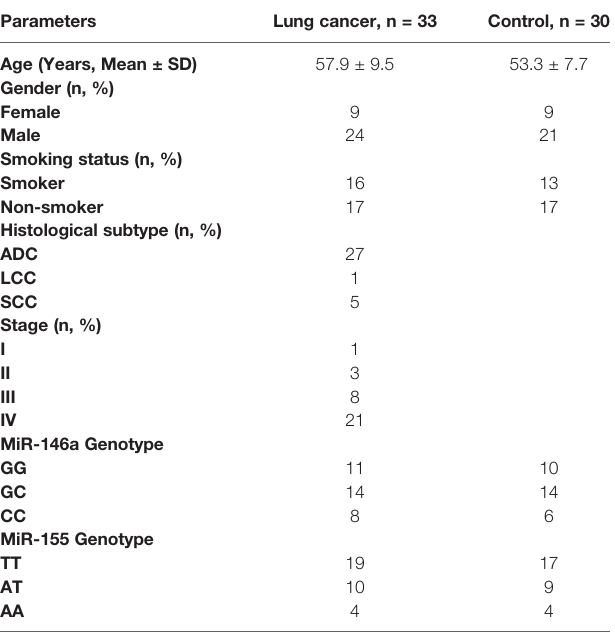
TABLE 1 | Demographic information of participants.